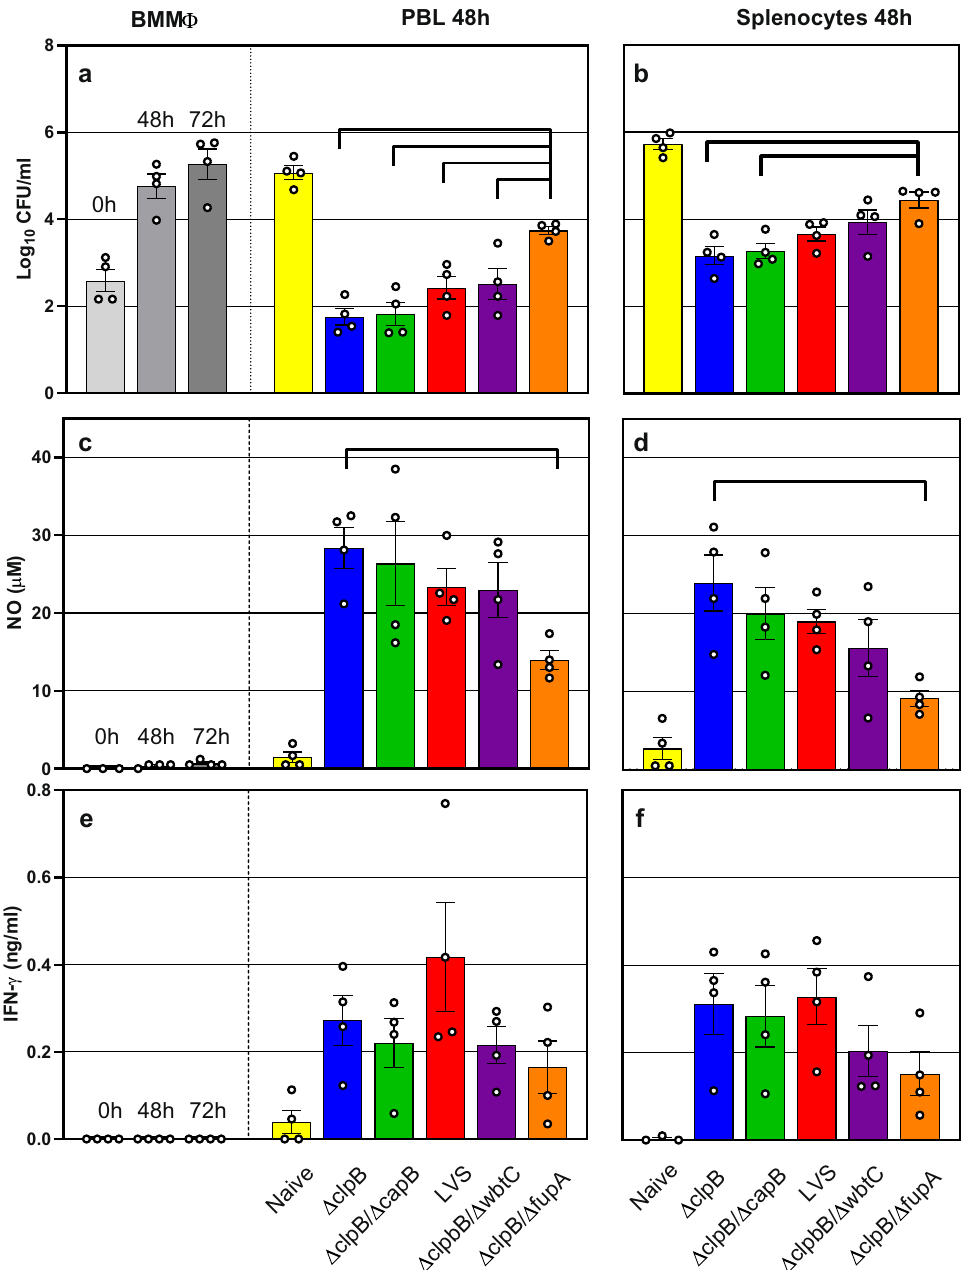
Fig. 2 Rat leukocytes control intramacrophage bacterial growth and effect mediator production in vitro in a pattern that suggests differential vaccine ef fi cacies. BMM Φ from Fischer 344 rats were infected with LVS and co-cultured with PBLs ( a , c , e ) or splenocytes ( b , d , f ) obtained from naive or vaccinated rats, as indicated. After 2 days of co-culture, BMM Φ were lysed to evaluate the recovery of intracellular bacteria ( a , b ). Supernatants were collected and analyzed for NO ( c , d ) and IFN- γ ( e , f ). Values shown are the average from four independent experiments of similar design. Error bars indicate standard error of the mean (s.e.m.). Brackets indicate signi fi cant differences among vaccine groups and calculated by two-way ANOVA and Tukey ’ s multiple comparison test ( P < 0.05). Symbols indicate values obtained from independent experiments. Not shown by brackets are the differences calculated with naive samples against all vaccine groups, which were signi fi cant, except vs Δ clpB - Δ fupA (CFU, spleen; NO, PBLs at 48 h; NO, spleen), vs Δ clpB - Δ capB (NO, spleen at 72 h), and vs Δ clpB - Δ wbtC (NO, spleen at 72